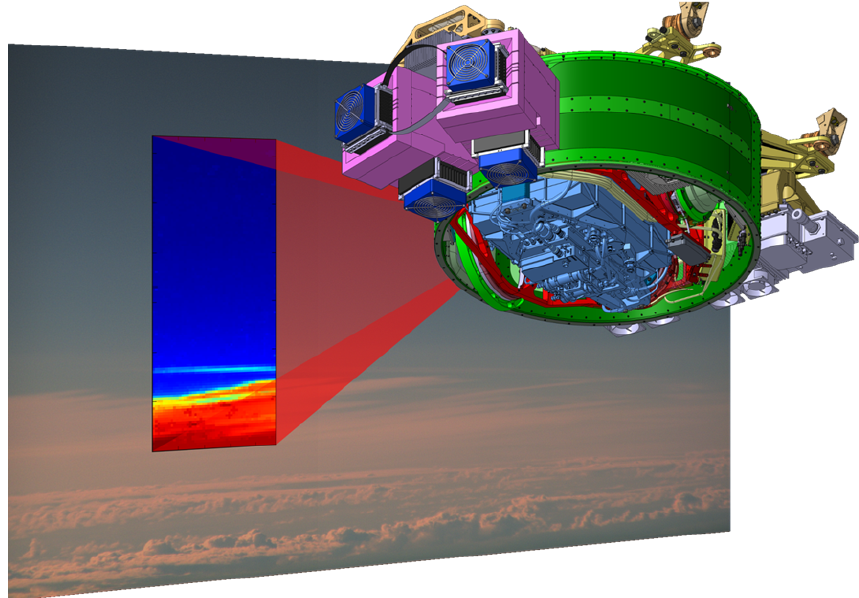
Figure 1. Schematic of the instrument and the measurement principle. Depicted is an overlay of an IR and a visual image together with a technical drawing of the